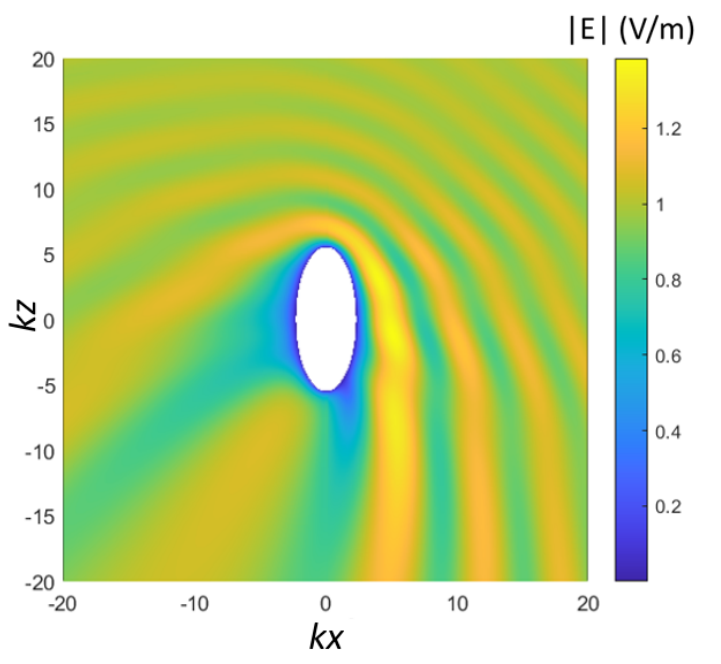
Figure 3. Magnitude of the E-field across the plane xz for the same geometrical parameters considered in Figure 2. TE polarization.